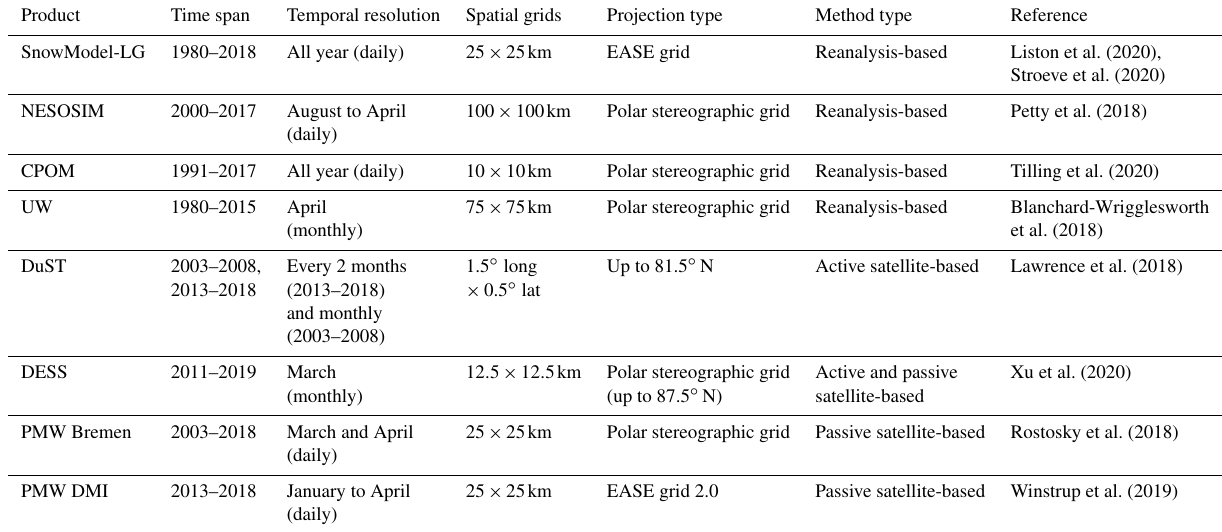
Table 1. Summary of investigated snow reconstruction